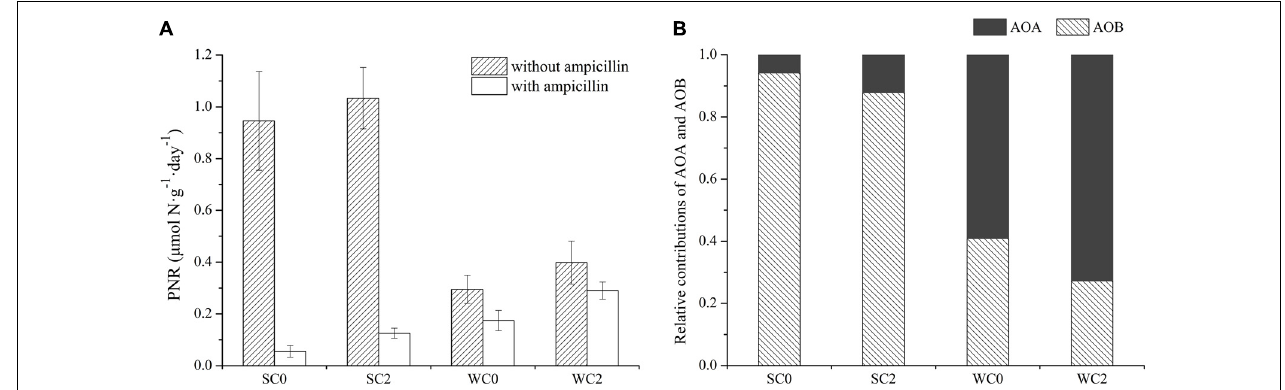
FIGURE 8 | Potential nitrification rates (PNR) analyses in surface sediments from adjacent waters of Rushan Bay. (A) PNR in surface sediments from adjacent waters of Rushan Bay incubated with and without ampicillin. The error bars are the standard deviations of triplicate incubations. (B) The relative contributions of AOA and AOB to ammonia